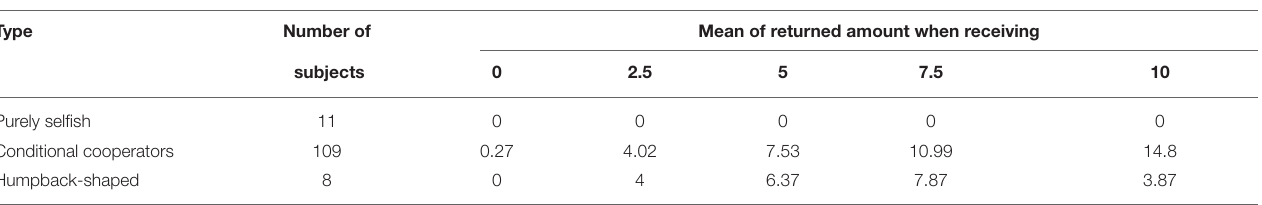
TABLE 2 | Categorization of subjects’ scenario 1 back transfers.